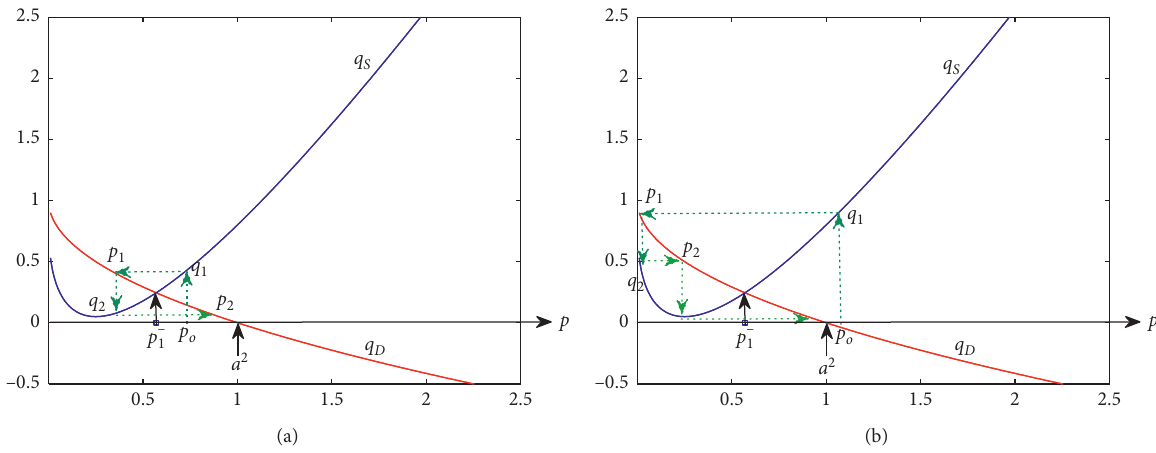
Figure 1: Dynamic steps for price and quantity for different initials of price. Parameters’ values are a � 1 , c � 0 . 2 ,k �